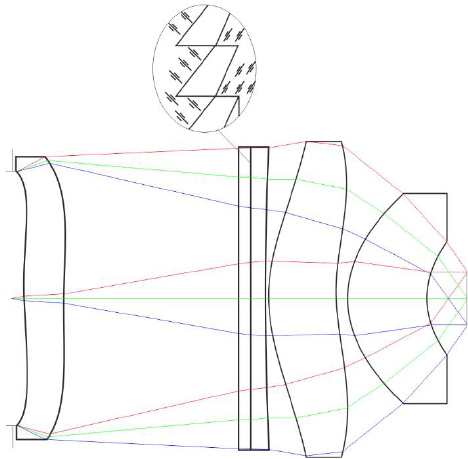
Figure 4. Optical layout of the refractive – diffractive version of the ultra-high-aperture athermal dual-range IR objective. Table 3. Design parameters of the refractive – diffractive version of the ultra-high-aperture athermal dual-range IR objective.